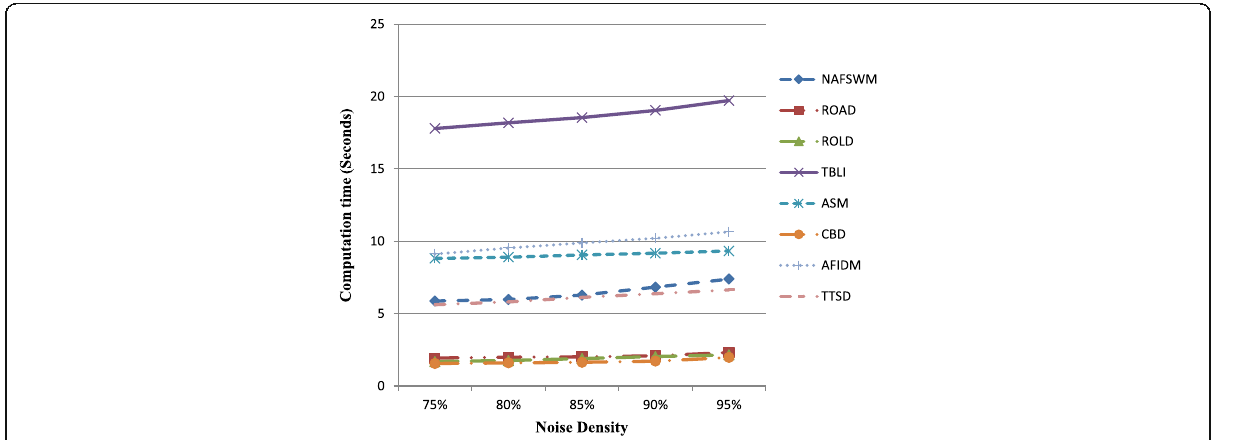
Fig. 12 Average computation time of various algorithms for TID2008 database corrupted by